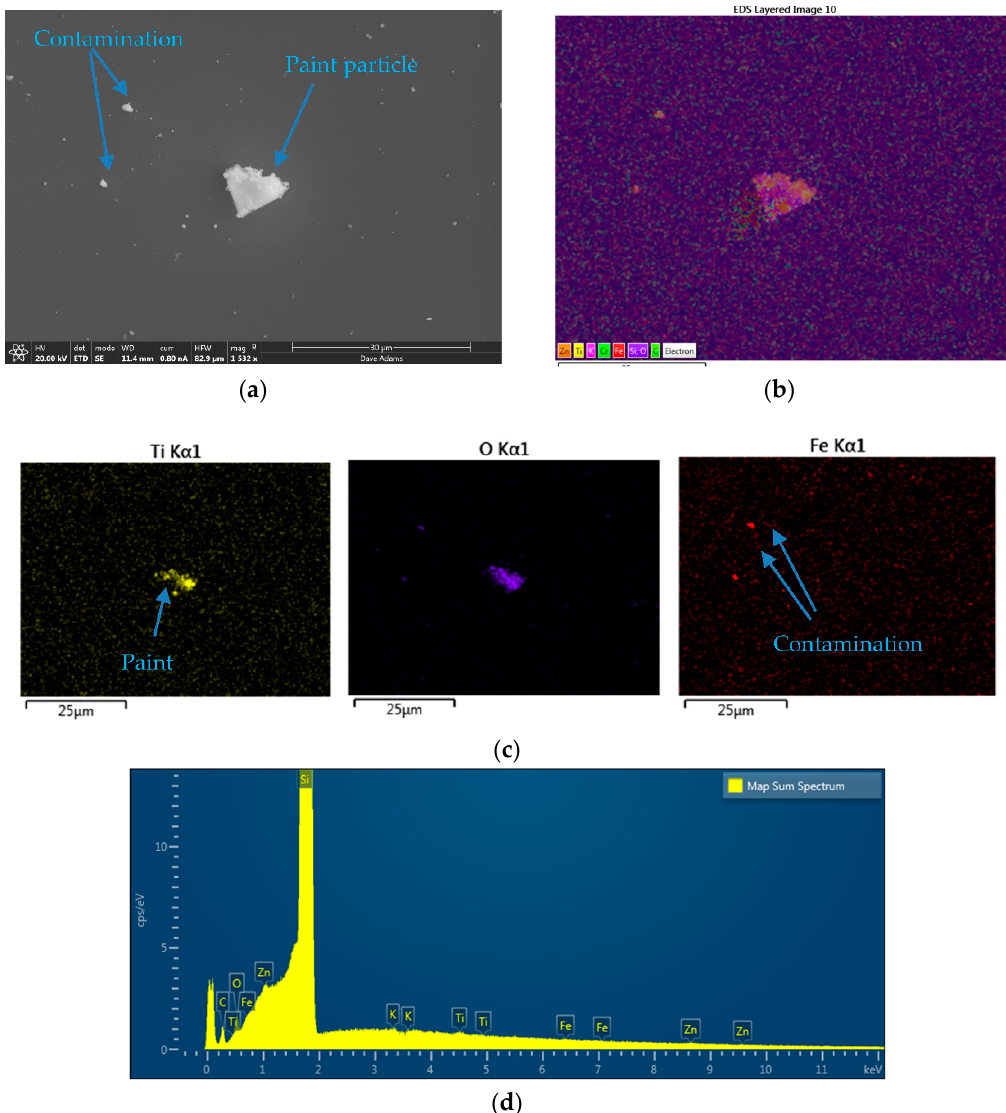
Figure 21. Examples in case studies. ( a ) SEM image, ( b ) EDX layer image, ( c ) EDX single-element image, and ( d ) EDX spectrum.